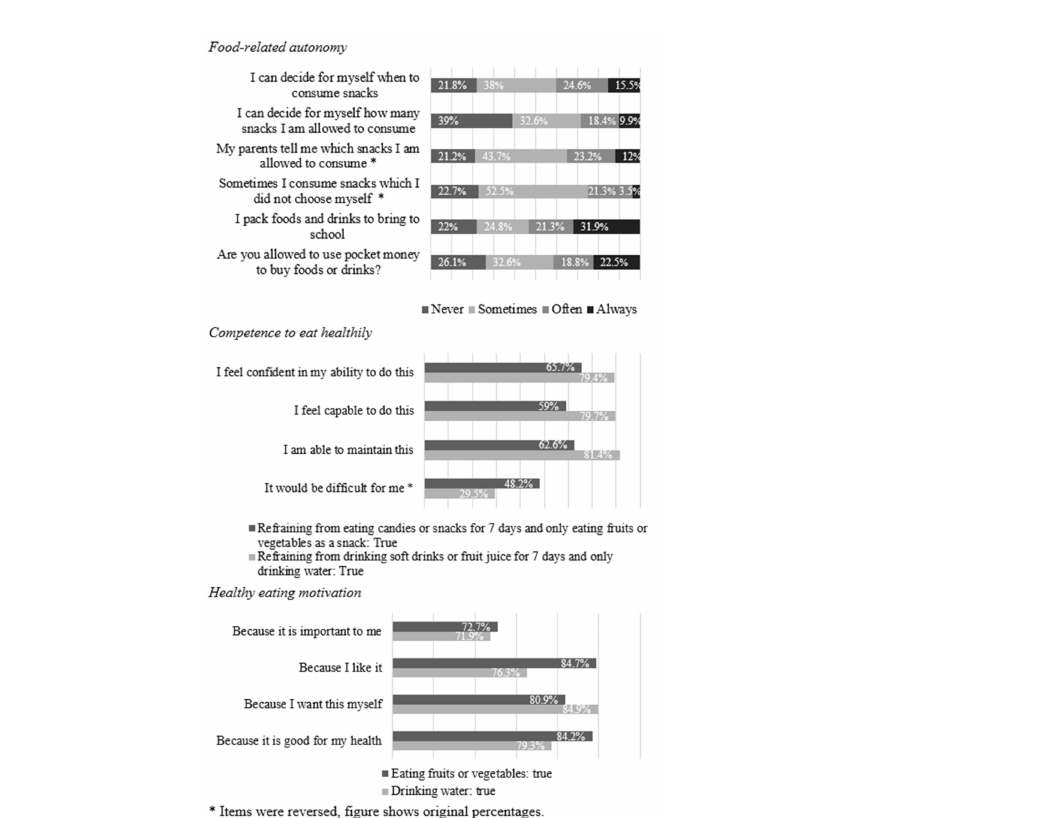
Figure 2. Percentage frequency distributions of items for food-related autonomy, competence to eat healthily and healthy eating motivation among preadolescents ( n =